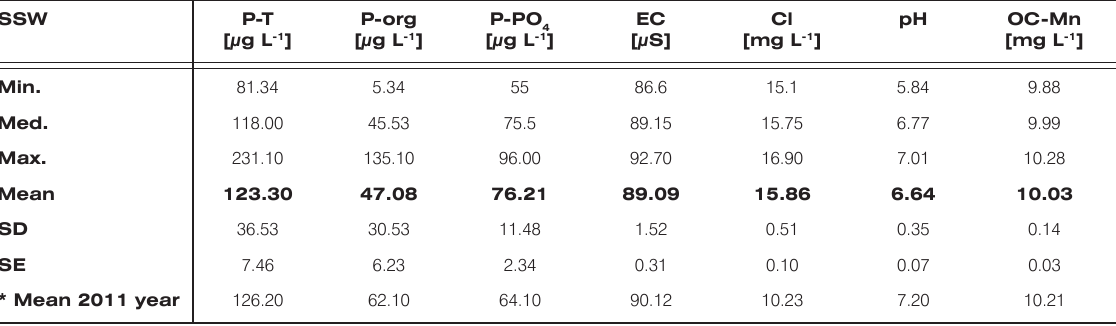
Table 1. Content of selected forms of phosphorus, chloride ions, conductivity, oxygen consumption and pH on subsurface water. Min. -minimum, med. - median, max. - maximum, SD – standard deviation, SE – standard error.